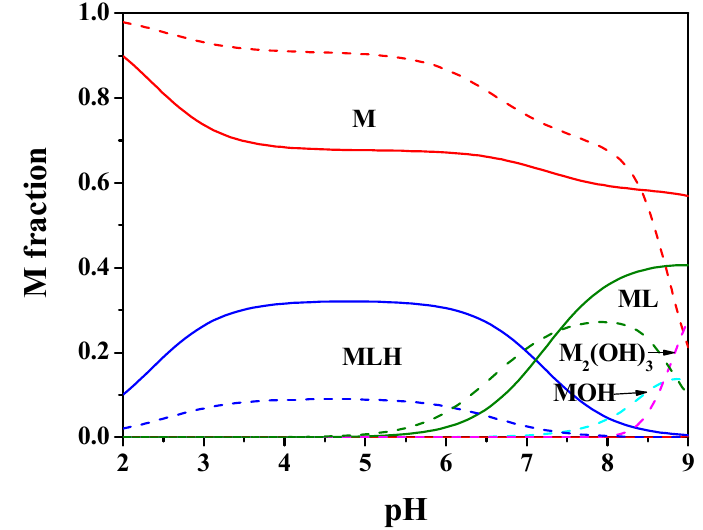
Figure 9. Speciation diagram of Mn 2 + - Amp (L) system, at C M = 2 mmol L − 1 , C L = 4 mmol L − 1 , I = 0.15 mol L − 1 , t = 15 °C (solid line), t = 37 °C (dashed line).